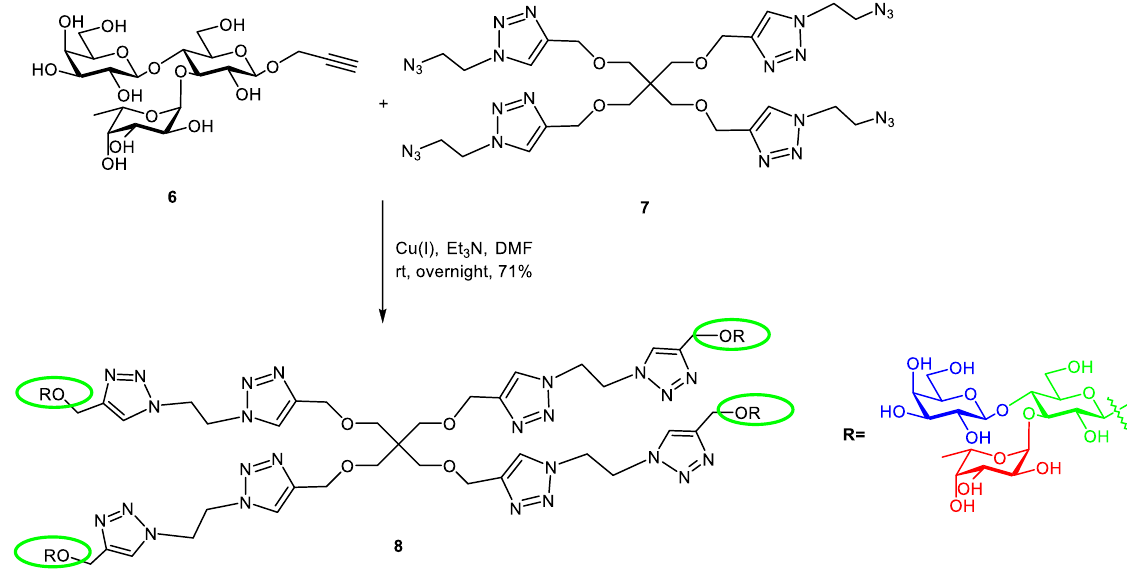
Scheme 3. Synthesis of the tetravalent glycocluster 8 having 3- O -fucosyl lactoside